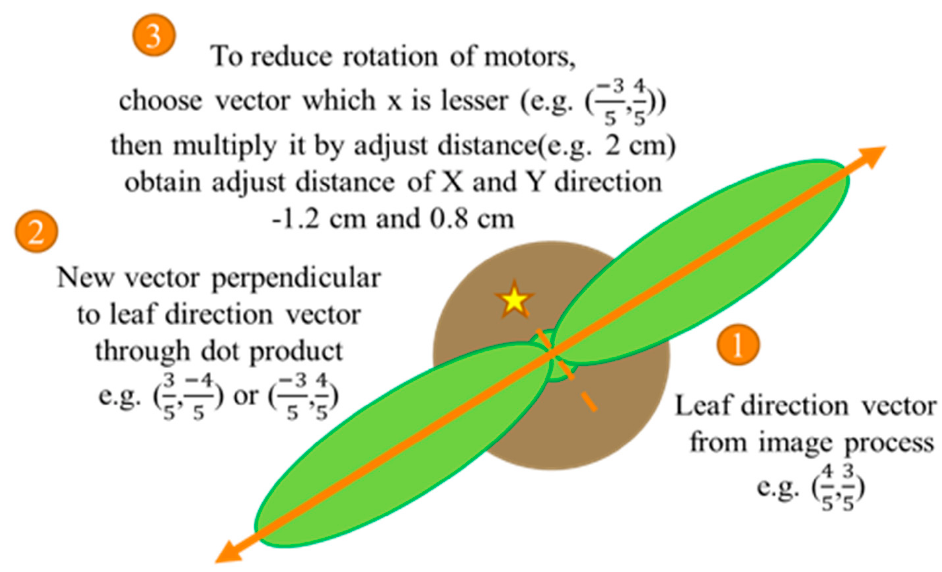
Figure 12. Elaboration on correction process of targeted watering point (stem-root junction).